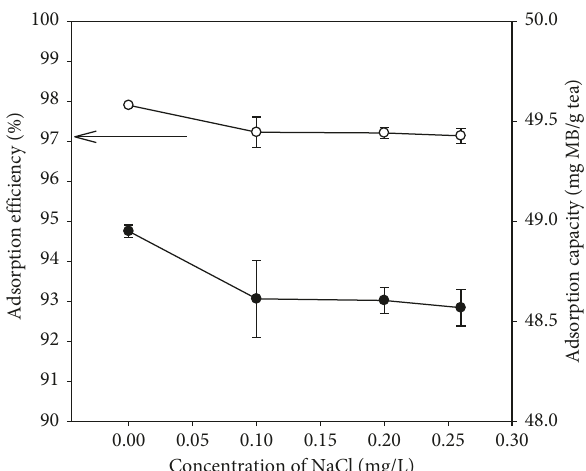
Figure 8: Effect of ionic strength on the adsorption efficiency and capacity of